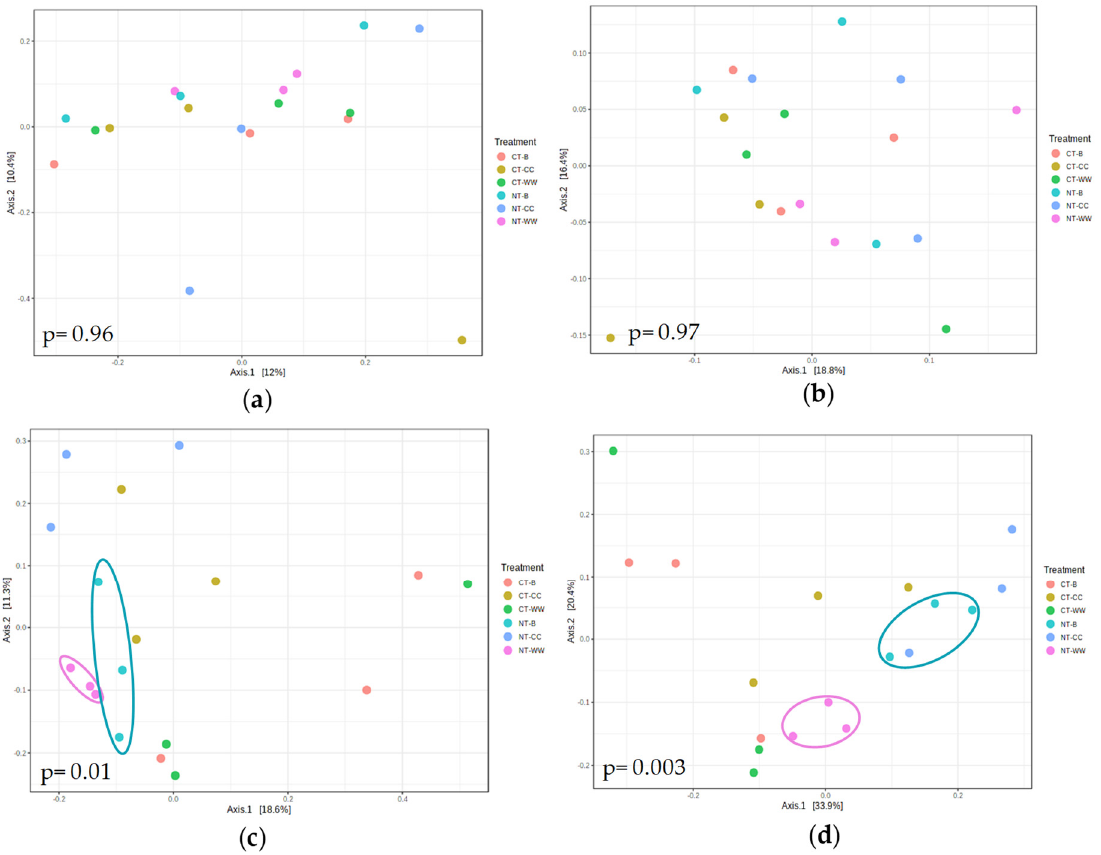
Figure 1. Principial coordinate analysis (PCoA) plot depicting the Bray–Curtis ( a , c ) and weighted UniFrac distance matrix ( b , d ) of bacterial ( a , b ) and fungal ( c , d ) communities under combination of crop rotation, tillage practice and winter cover management systems. (CT-B: Conventional